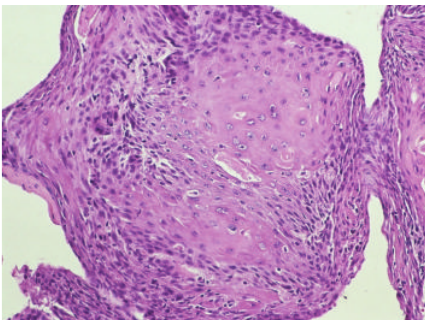
Figure 7: Biopsy of the vocal cord showed invasive well differen- tiated squamous cell carcinoma showing cohesive nests and intra- cytoplasmic keratinization.